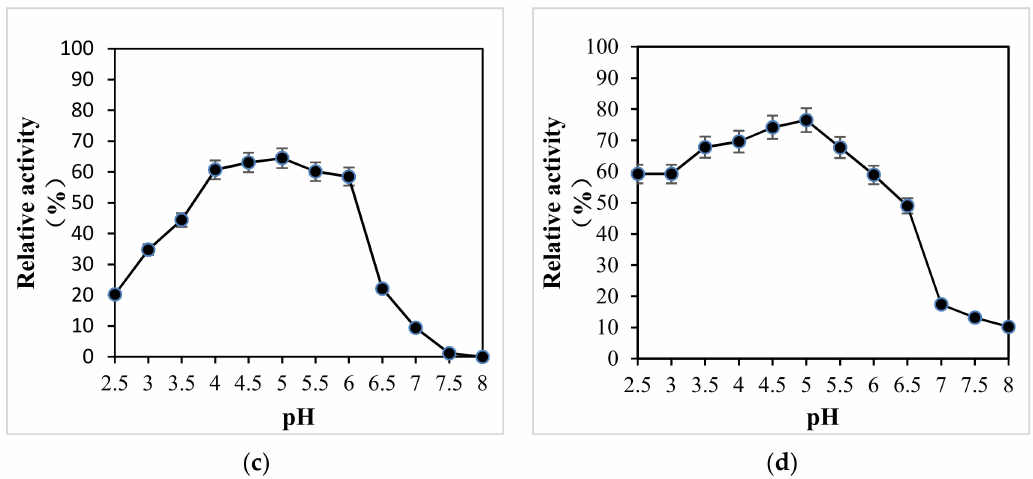
Figure 5. pH stability of all strains. ( a ) X33-Lac-2; ( b ) native Pleurotus ostreatus ; ( c ) X-33 Pichia pastoris ; ( d ) empty pGAPZ α A plasmid yeast.